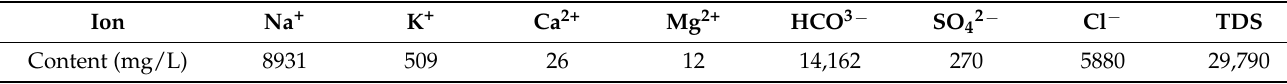
Table 1. Ion composition of synthetic formation